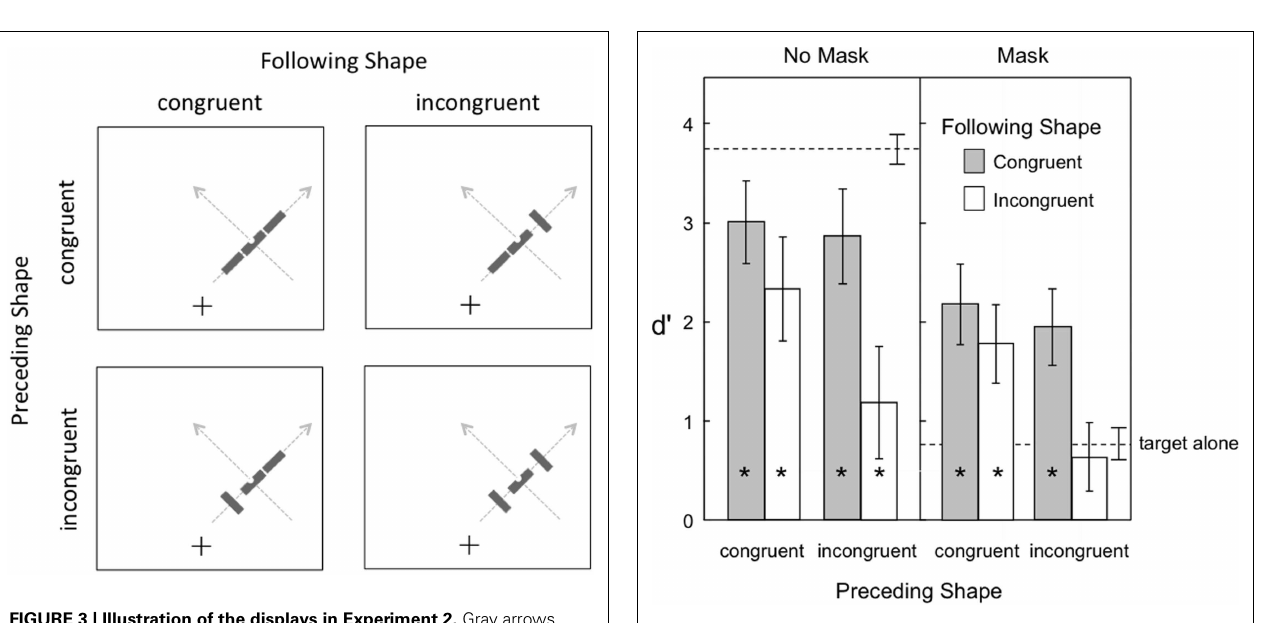
FIGURE 4 |Visibility of the target in Experiment 2, as indexed by d (cid:48) in a shape-discrimination task. Error bars represent ± 1 SEM.The asterisks indicate those conditions in which target visibility was significantly reduced or increased relative to the target alone